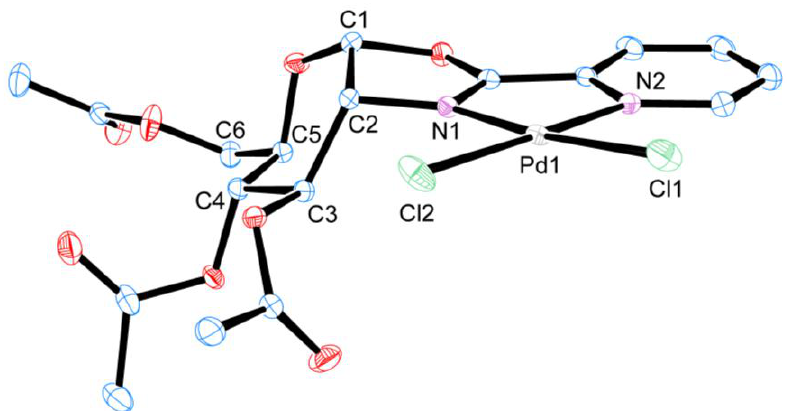
Figure 3. ORTEP plot of the molecular structure of the Pd complex 6 . Hydrogen atoms have been omitted for clarity; ellipsoids are given at the 50% probability level. Blue = carbon; red = oxygen; pink = nitrogen; grey = palladium; green = chlorine. Selected bond-distances (Å ) and -angles (°): Pd1-N1 2.0284(14), Pd1-N2 2.0439(15), Pd-Cl1 2.2779(5), Pd-Cl2 2.2692(5); N1-Pd-N2 80.70(6).